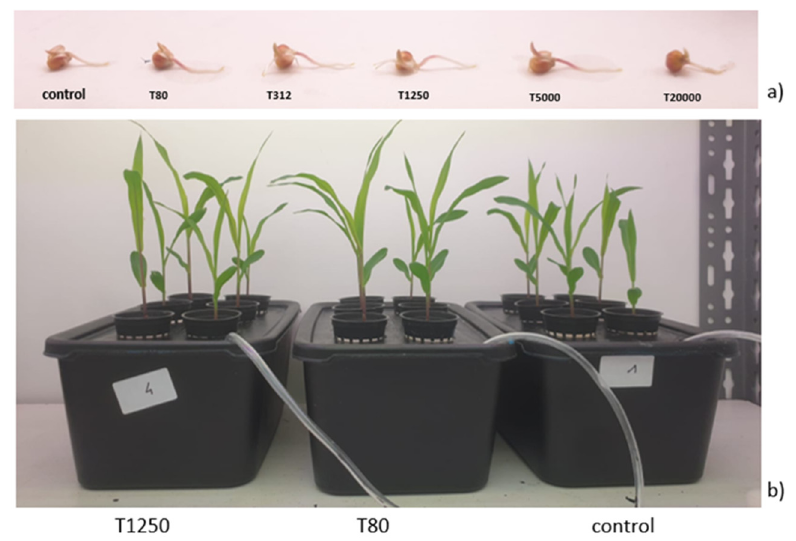
Figure 2. Representative seeds at 4 days after treatment with the various LNP concentrations (T80, T312, T1250, and T5000 refer to LNP concentration applied to seed for priming ( a ); representative samples at 14 days after the treatment with LNP (T80 and T1250 refer to the LNP concentrations used for seed priming ( b ).